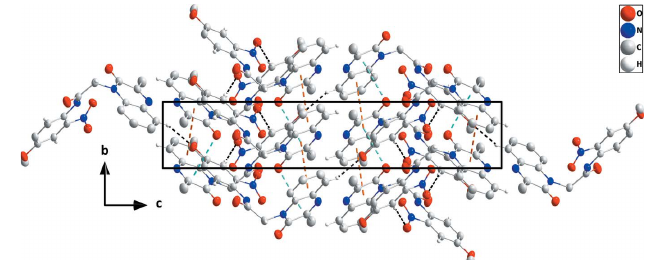
Figure 3 Packing viewed along the a -axis direction with C—H (cid:3)(cid:3)(cid:3) O hydrogen bonds depicted by black dashed lines. Slipped (cid:2) -stacking and C O (cid:3)(cid:3)(cid:3) (cid:2) (ring) interactions are depicted, respectively, by orange and light-blue dashed lines. Non-interacting hydrogen atoms are omitted for clarity.